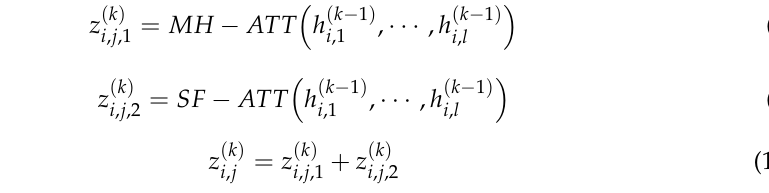
the hidden state calculated with the 𝑘 th layer. Then 𝑧 (cid:3036),(cid:3037),(cid:2869)(cid:4666)(cid:3038)(cid:4667) and 𝑧 (cid:3036),(cid:3037),(cid:2870)(cid:4666)(cid:3038)(cid:4667) . 𝑧 (cid:3036),(cid:3037)(cid:4666)(cid:3038)(cid:4667) were integrated